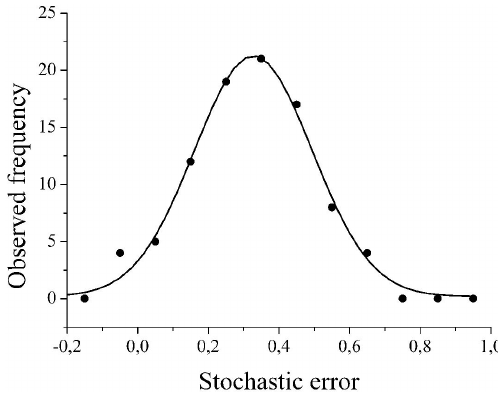
Fig. 9. The frequency distribution for the relative variance between measured and computed flux is illustrated. Using a Gaussian fit the stochastic error of the computed flux can be approximated. The median error of 33% corresponds to the evaluated theoretical error of